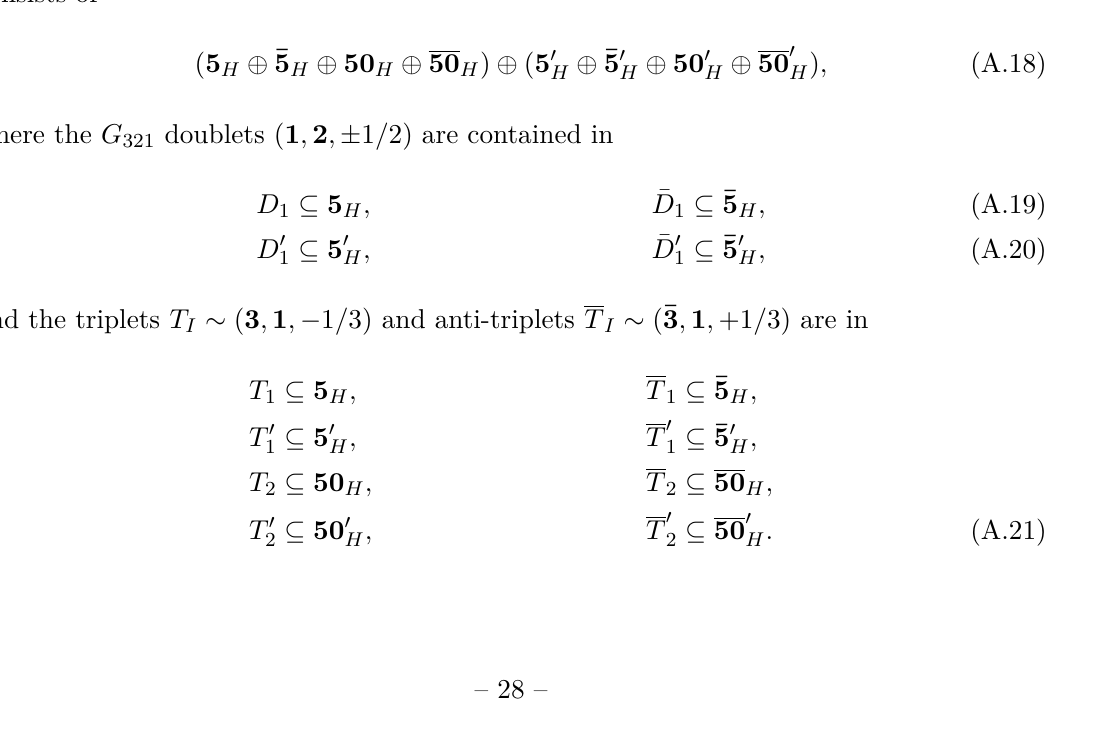
while precision of the tuning in the parameter ˜ m mass M eff T